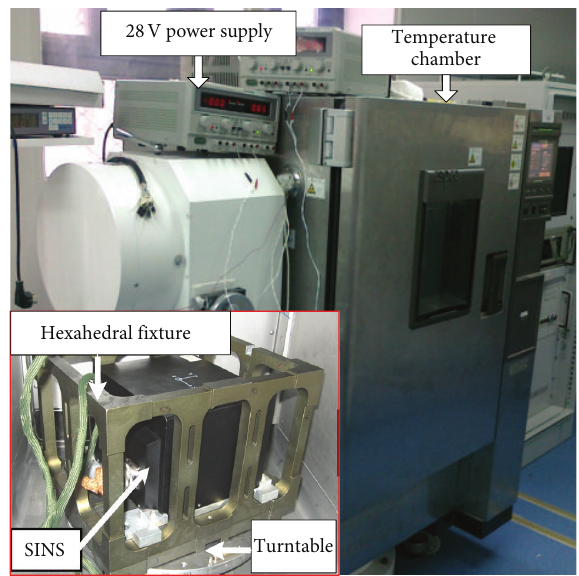
Figure 3: The single-axis turntable with temperature control for the calibration